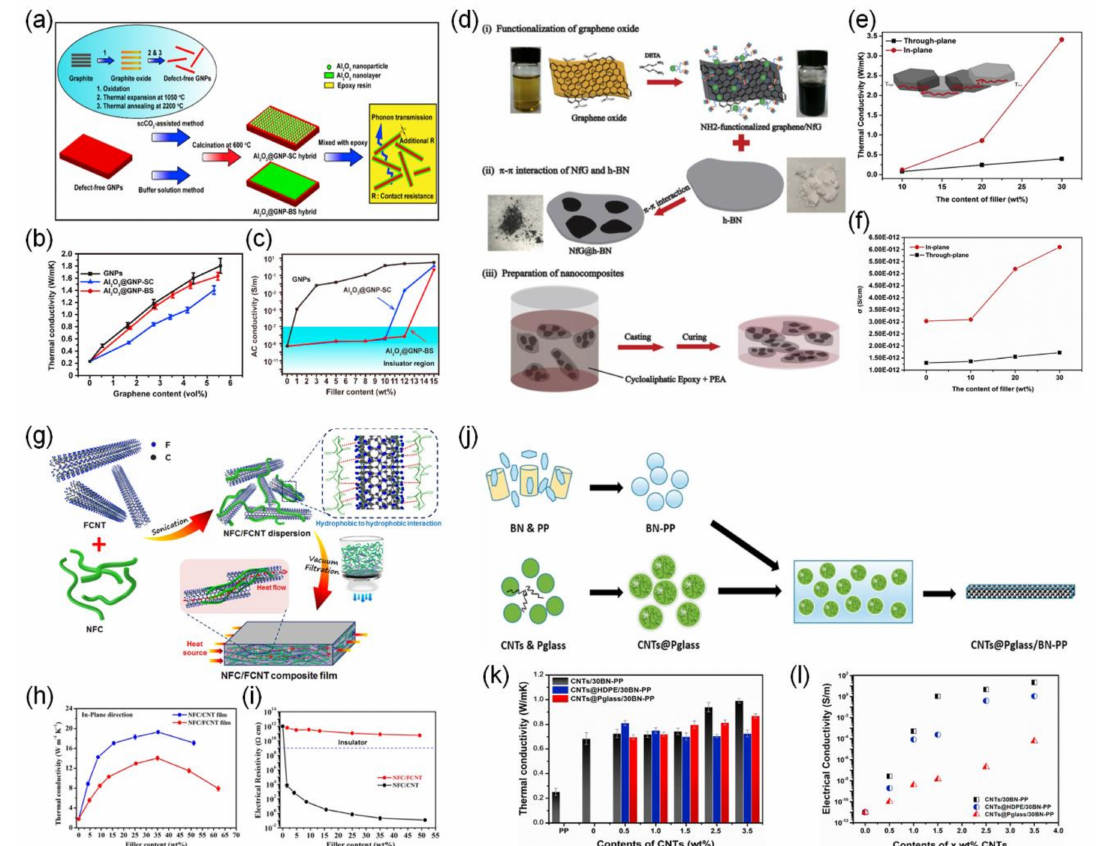
Figure 5. ( a ) Schematic illustration of the synthesis routes of Al 2 O 3 @GNP hybrids and their epoxy composites. ( b ) Comparison of electrical conductivities of epoxy composites filled with GNPs and their hybrids at 100 Hz. ( c ) Plots of thermal conductivity versus the GNP volume content of epoxy composites [35]. Copyright Elsevier. ( d ) Schematic illustra- tion of the procedure to prepare the flexible composites. ( e ) Thermal and ( f ) electrical conductivities of CER/NfG@h-BN as a function of the filler content [36]. Copyright Elsevier. ( g ) Schematic illustration of the preparation of the NFC/FCNT composite films. ( h ) Thermal and ( i ) electrical conductivities of the NFC/FCNT and NFC/CNT composite films with different filler loadings [38]. Copyright the American Chemical Society. ( j ) Schematic illustration of the fabrication procedure for CNTs@Pglass/BN-PP. ( k ) Thermal and ( l ) electrical conductivities of CNTs@Pglass/30BN-PP as a function of the CNT content [40]. Copyright